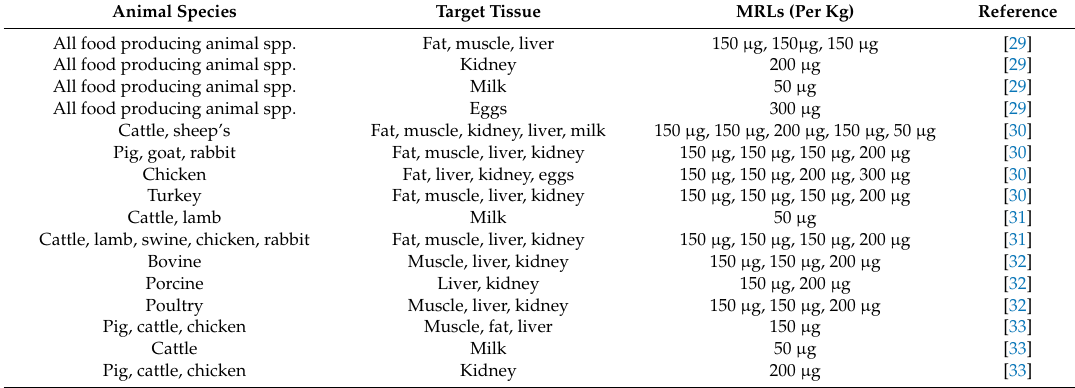
Table 1. Maximum residue limits (MRLs) of colistin recommended in animal-based food by di ff erent regulatory agencies. Animal Species Target Tissue MRLs (Per Kg) Reference All food producing animal